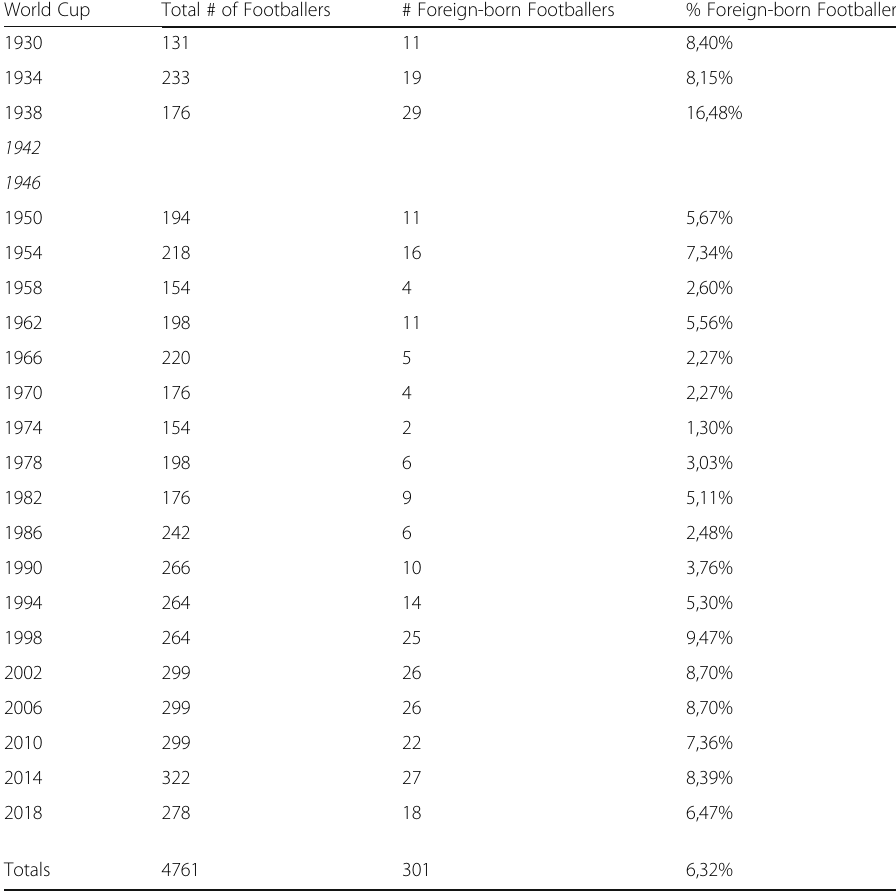
Table 1 Absolute and relative numbers of foreign-born football players within the fifteen selected national teams per World Cup, 1930 – 2018 World Cup Total # of Footballers # Foreign-born Footballers % Foreign-born